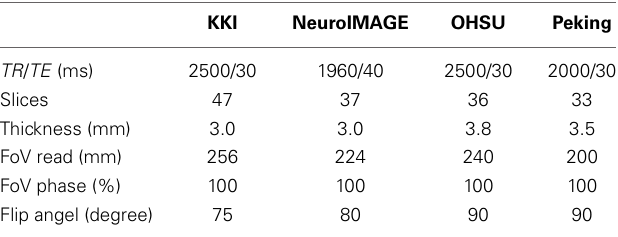
Table 2 | Table lists the summary of scan parameters for all the data